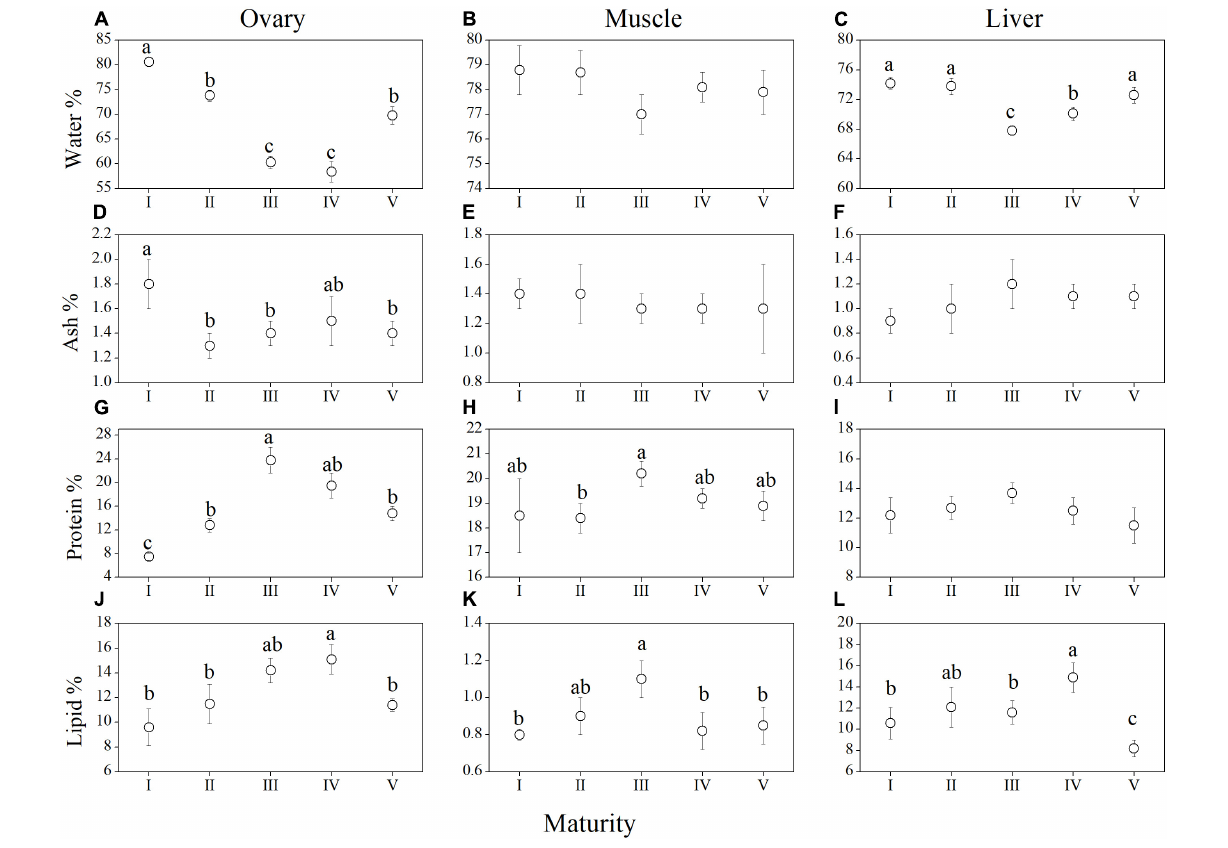
Frontiers in Ecology and Evolution |